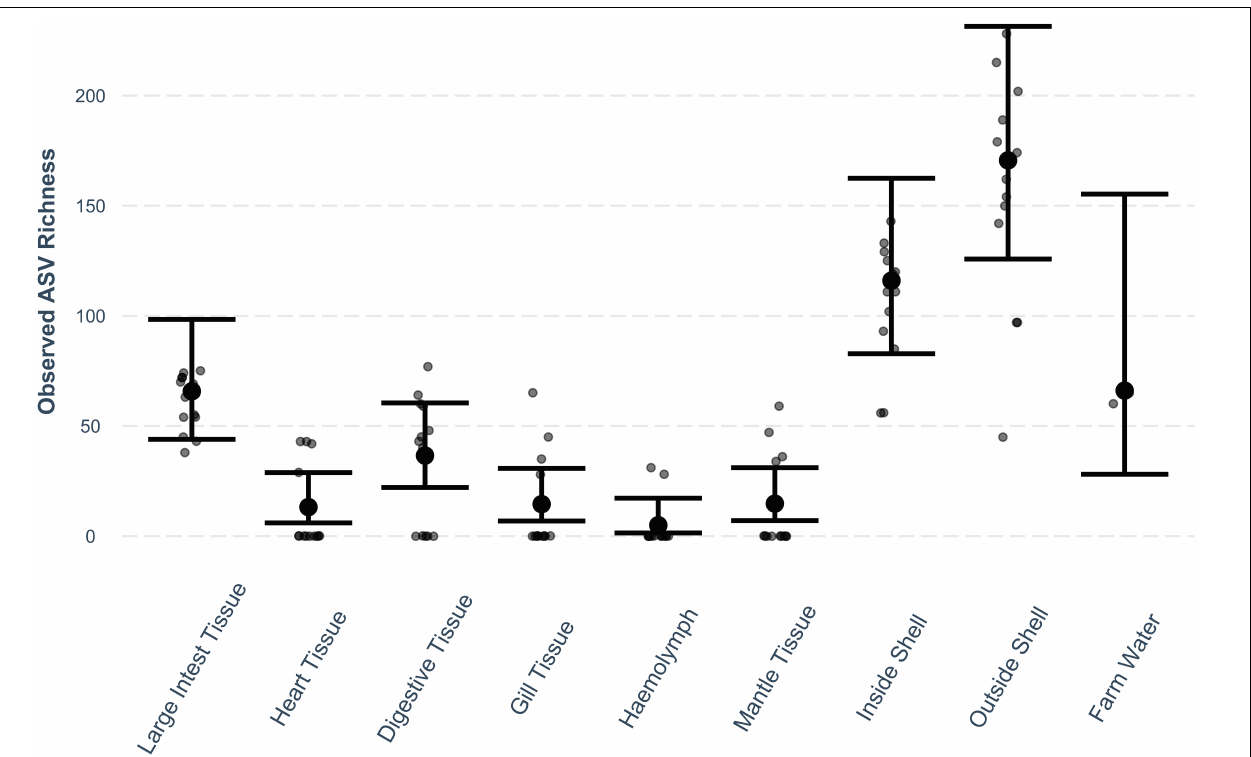
FIGURE 1 | Observed ASV richness (small dots) across oyster tissue types and farm water. Mean estimates (large dots) are based on a quasi-Poisson model with fixed factors oyster tissue type and location. Error bars mark 95% confidence intervals.